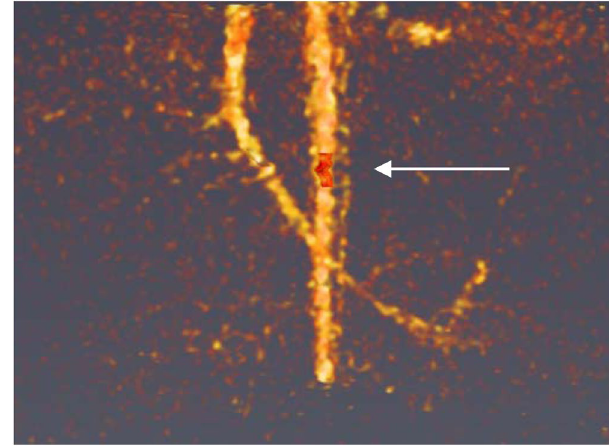
Figure 8. Delimited box (in red) for Gd 3 + quantification in the